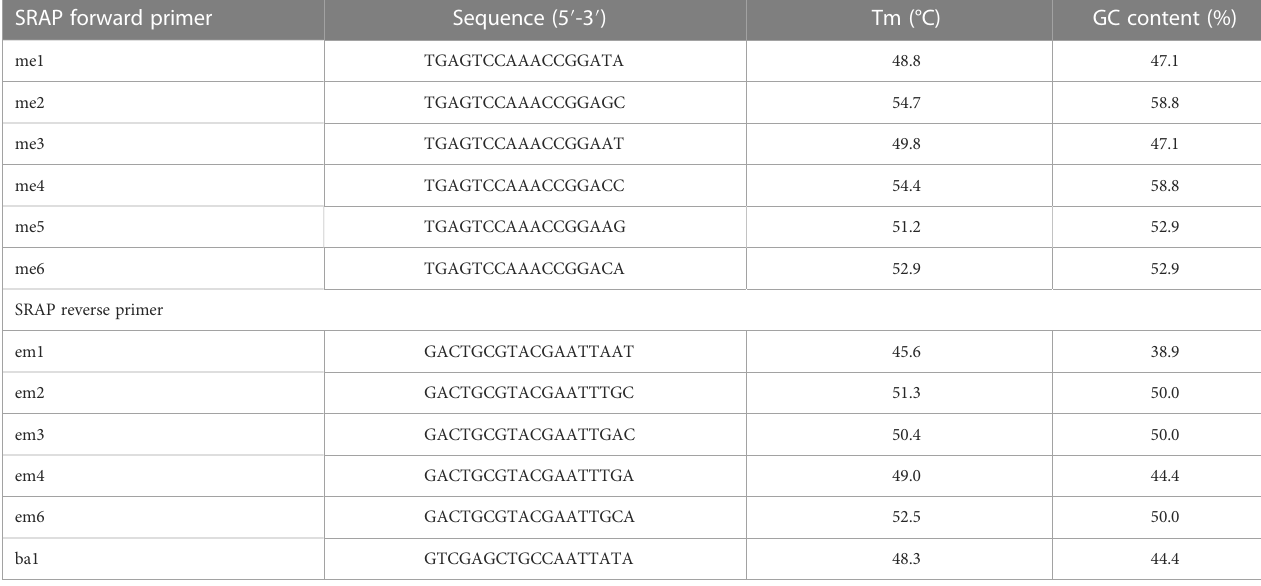
TABLE 1 Forward and reverse SRAP primer sequences used in the study. SRAP forward primer Sequence (5 ′ -3 ′